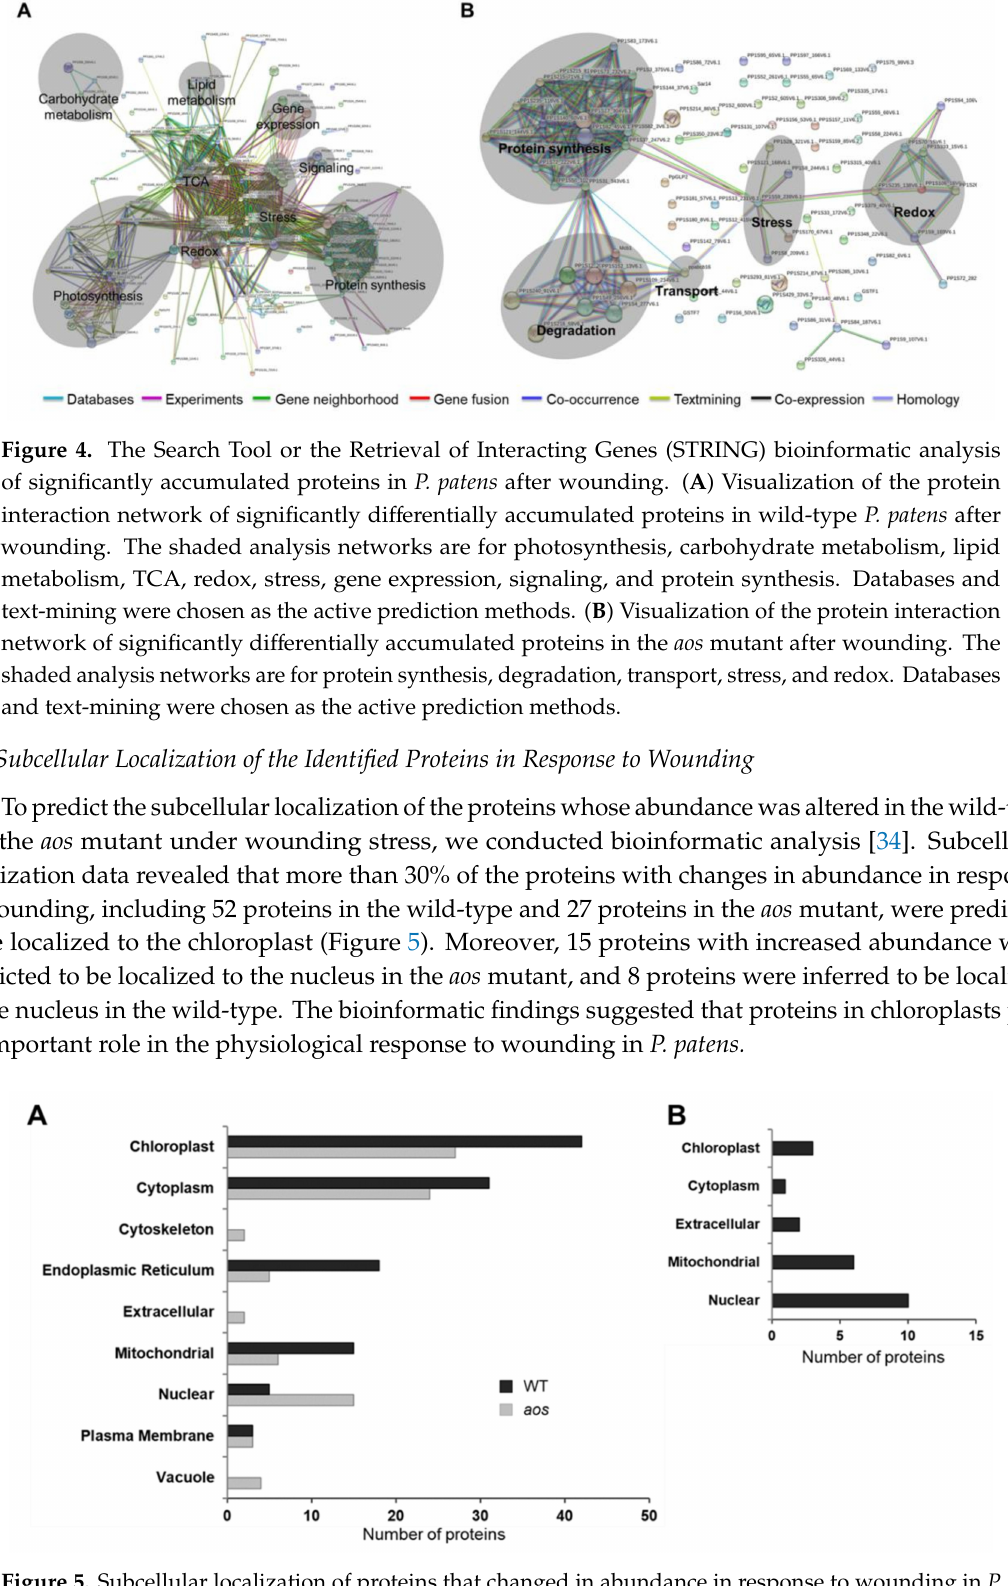
Figure 5. Subcellular localization of proteins that changed in abundance in response to wounding in P. patens wild-type and the aos mutant. ( A ) Increased proteins. ( B ) Decreased proteins. The subcellular localization of the identified proteins was predicted using TargetP, Bacello, and WoLF